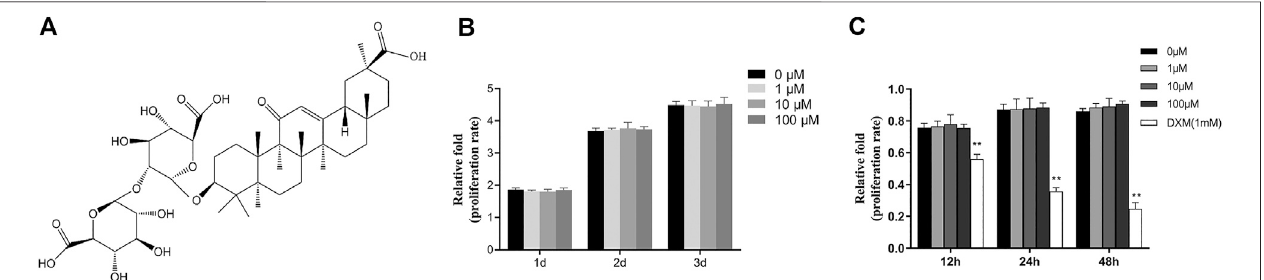
FIGURE1| GAhadnoeffectontheviabilityorproliferationofhBMSCs. (A) ThechemicalstructureofGA. (B) TheproliferationofhBMSCswasmeasuredbyCCK-8 assay after addition of different concentrations of GA (0 – 100 μ M) for 1, two or 3 days in hBMSCs growth medium. (C) The proliferation of hBMSCs was measured by CCK-8 assay after addition of different concentrations of GA (0,1,10 and100 μ M) and dexamethasone (DXM 1 mM) for 12, 24 and 48 h in hBMSCs basal medium with 1% FBS. The proliferation rate was normalized relative to that of group GA 0 μ M.